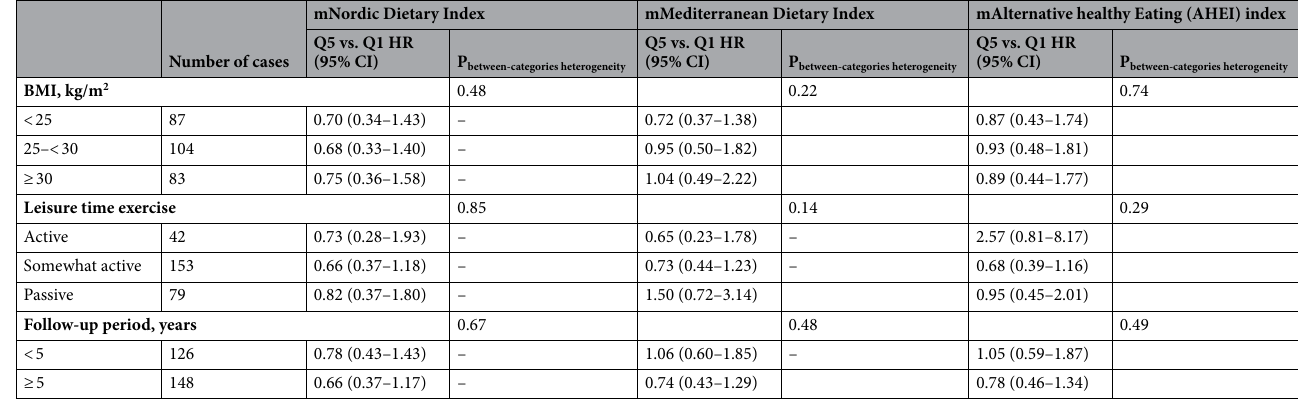
Table 4. Hazard ratios (HR) [Multivariable model was adjusted for age (years), education (tertiles by birth year), smoking (never, former, current smokers), height (cm, continuous), body mass index (kg/m 2 , continuous), leisure time exercise (passive, somewhat active, active), parity (never, ever), hormone replacement therapy (never, ever), energy intake (kJ/day, continuous) and cohort. The specific stratification factor was excluded from the model] and confidence intervals (95% CI) of postmenopausal breast cancer for dietary indices (Quintile 5 vs. Quintile 1) by the categories of body mass index and leisure time